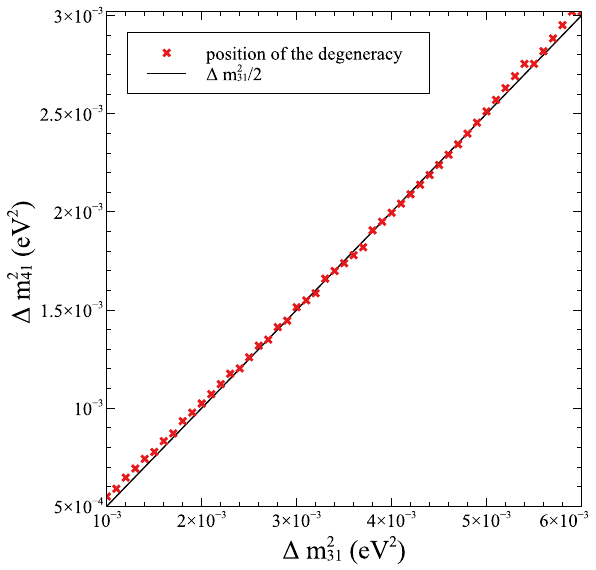
Fig. 5 χ 2 as a function of (cid:2) m 2 as a function of 41 red solid curve is for DUNE far detector only, the magenta dotted curve is for DUNE near detector, and the blue dashed curve is for near and far detector